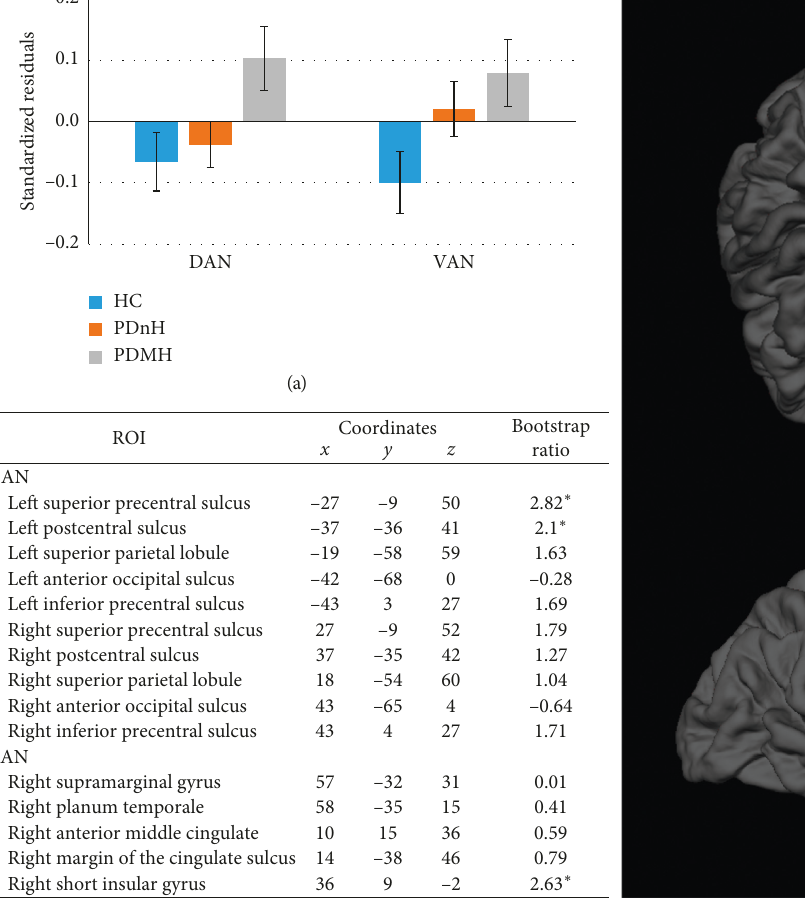
left frontal eye fields; light blue left inferior parietal (cid:31) (cid:31)